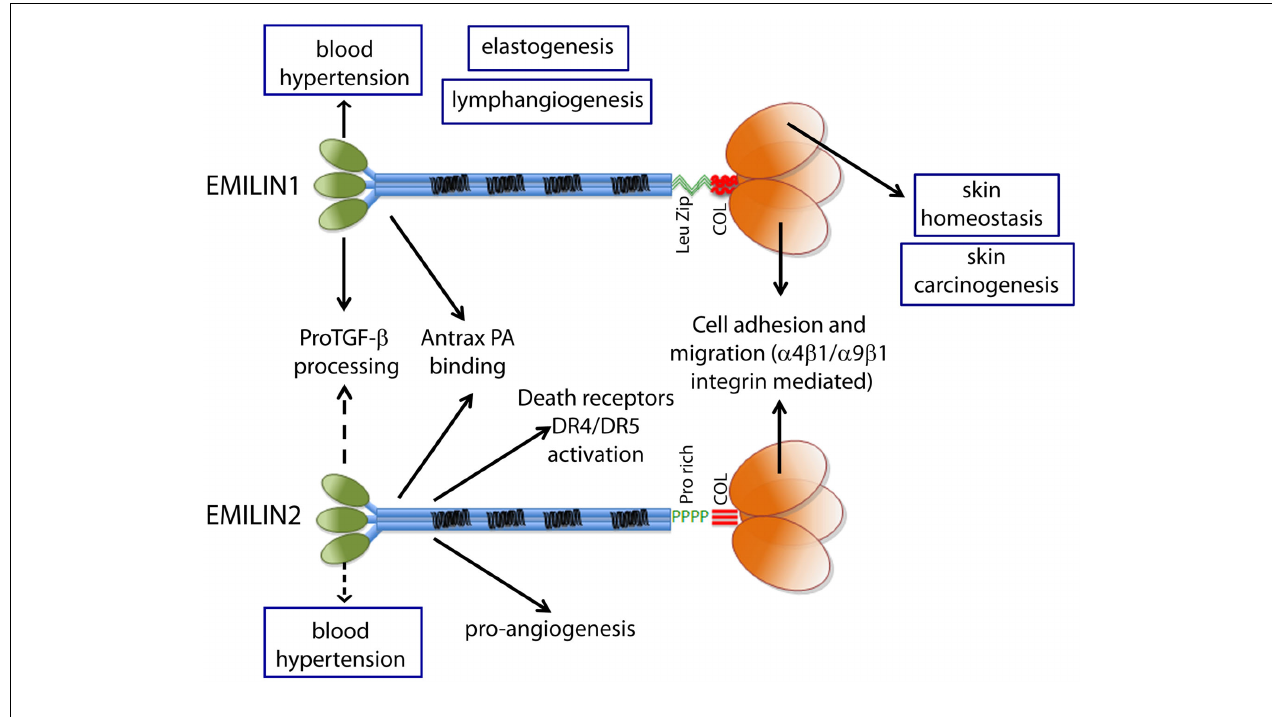
and of lymphangiogenesis have not yet been pinpointed to a specific domain although it is tempting to assume that gC1q plays an important